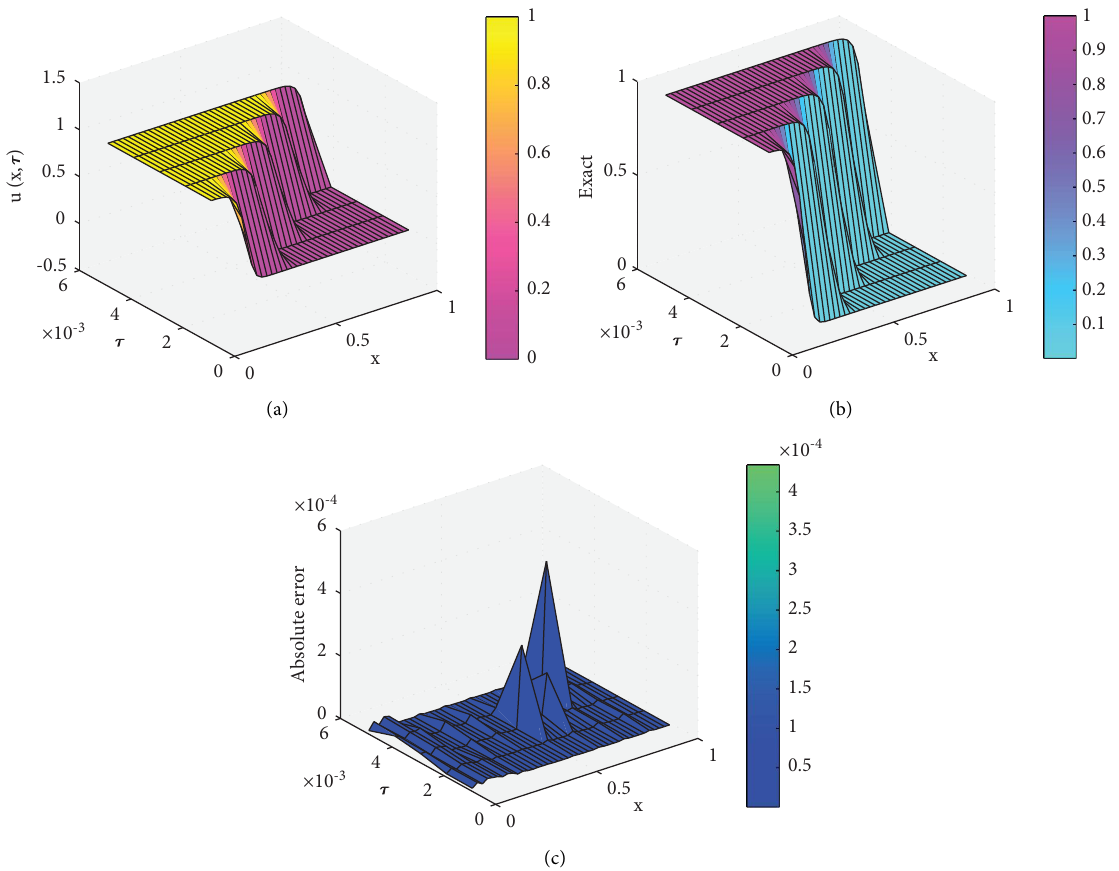
� 10000, k � 4 , and M � 5. 2 � 2000 of Example 4 at 2